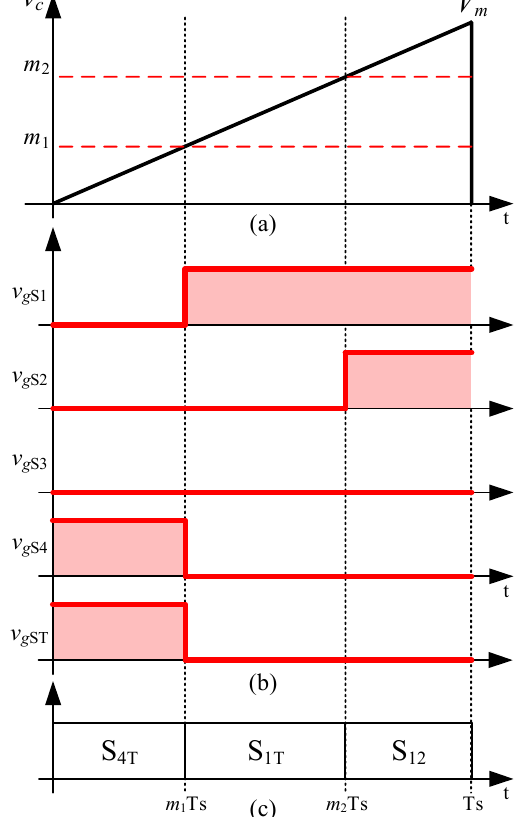
Figure 6. Reverse mode: the carrier-based modulation scheme. ( a ) Carrier and modulating signals; ( b ) gating signals of the switches; ( c ) states of operation.